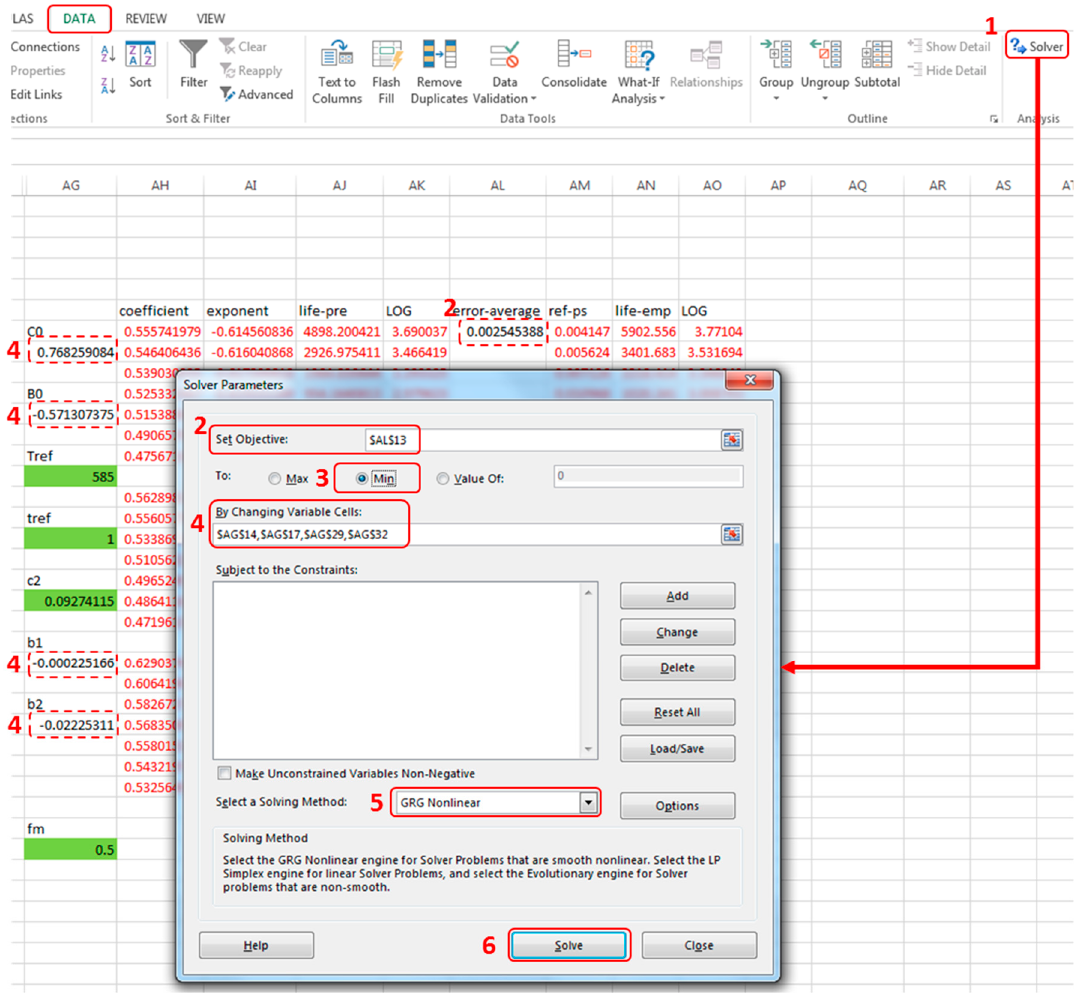
Figure A1. Spreadsheet method for numerical optimization, using Excel ® .